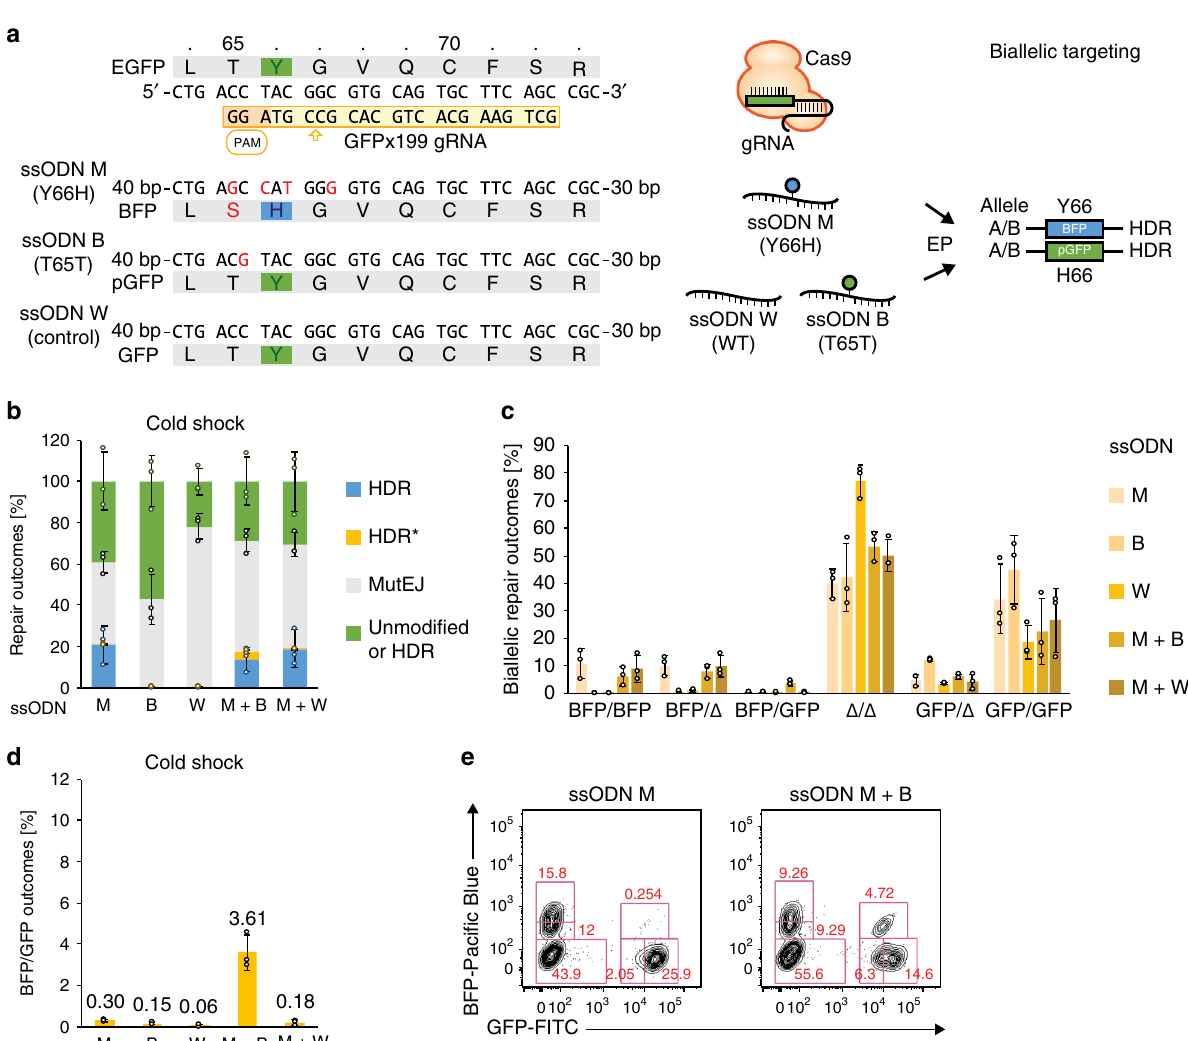
with N + S treatment. At the other 5 loci ( KCNE1 D85N, KCNH2 N45D, SCN5A A1428S, and KCNJ11 T293N/T294M), total editing ef fi ciency was low as shown by the greater proportion of unmodi fi ed wild-type clones, suggesting poor gRNA activity. In this case, between 0 and 8 out of 32 HDR clones or 0 to 25% HDR ef fi ciency was achieved. Similarly, HDR/MutEJ ratios were improved with synergistic gene editing, with a stronger effect observed in most cases for XL413 compared to cold shock (Fig. 6h). In summary, these results con fi rm that synergistic gene editing via cell-cycle synchronization and DNA repair pathway modulation is transferrable between electroporation instruments and to other iPS cell lines, resulting in the ef fi cient clonal generation of homozygous and compound heterozygous muta- tions at multiple endogenous loci.